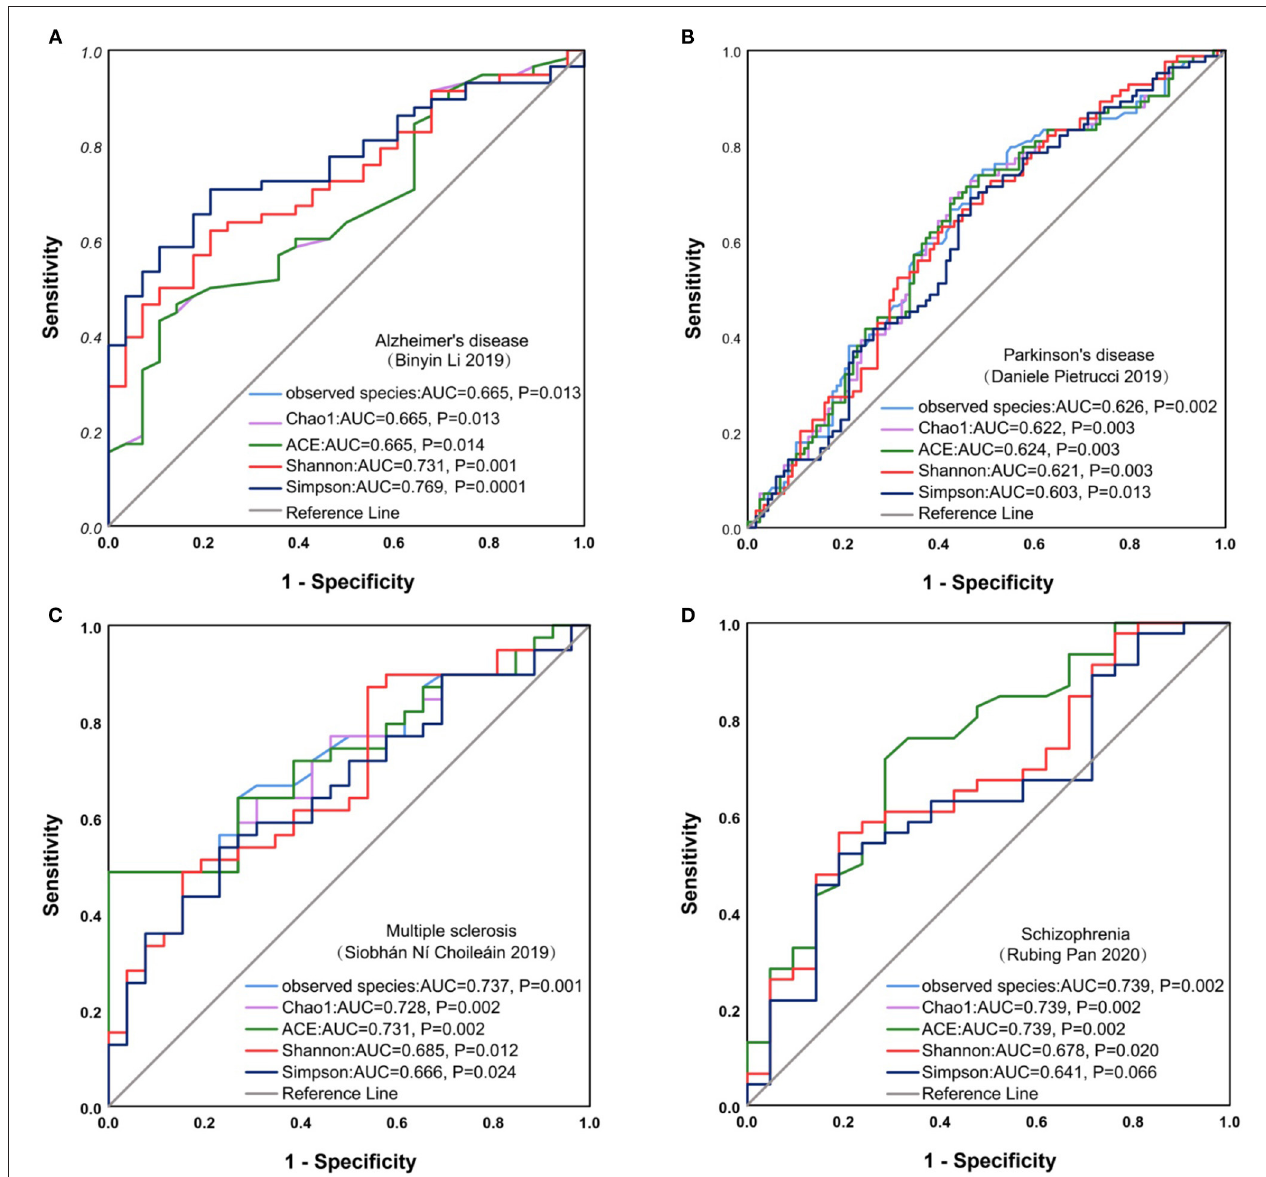
FIGURE 8 | ROC curve analysis on neurological diseases. ROC curve for Alzheimer’s disease (A) , Parkinson’s disease (B) , Multiple sclerosis (C) , Schizophrenia (D) . ROC, receiver operating characteristic; AUC, area under the